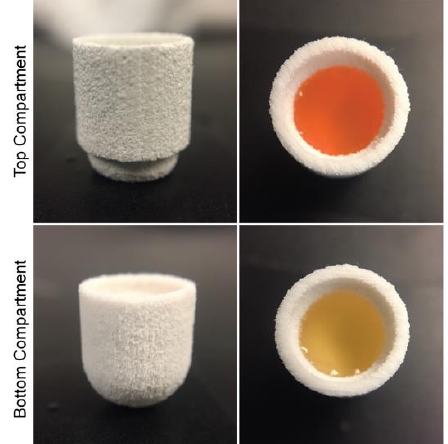
Figure 8. Multi-compartment preform tablet loaded with hydrophilic (bottom) and hydrophobic (top) bioinks.